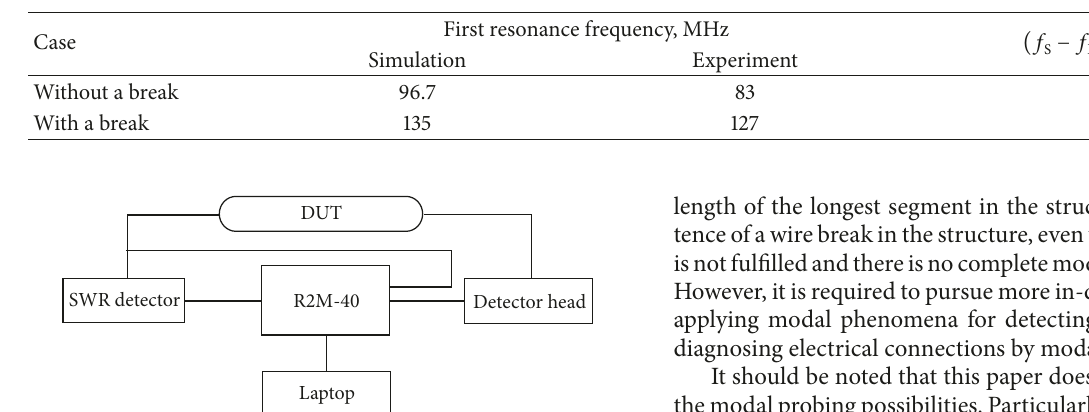
Table 9: Calculated and measured values of the first resonance frequency spectrum of the signal.